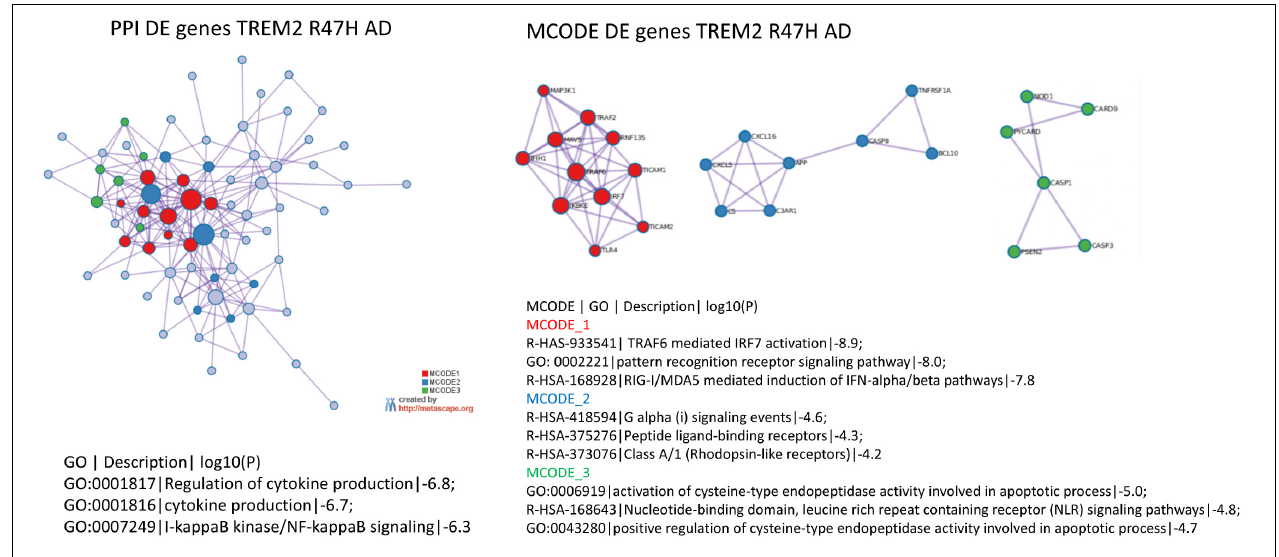
FIGURE 3 | Protein–protein interaction networks and its tightly connected cores (molecular complex detection) formed by differentially expressed genes in TREM2 R47H AD. Protein–protein interaction, molecular complex detection, and Gene Ontology (GO) term enrichment were determined using Metascape (www.metascape.org). 800 genes on NanoString panel were used as a background for enrichment calculations. Tables with the corresponding GO term enrichment are shown. Column heading in table: GO, GO ID; Description: Representative GO term; Log10(P), p -value for